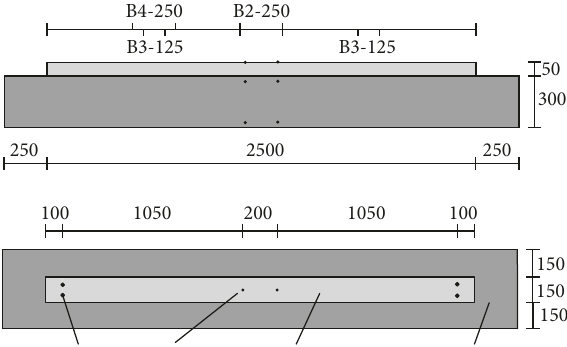
Figure 3: Vertical and horizontal view of test setup for shrinkage cracking testing for plain concrete beams [6]. For beams B2, B3, and B4, positions and length of initial debonding are shown.